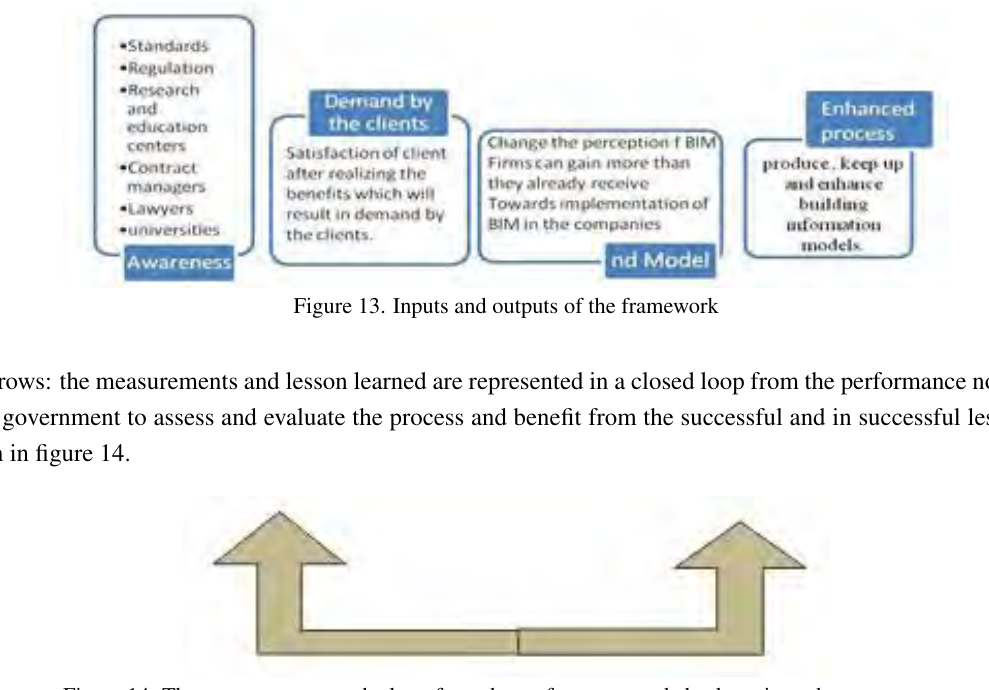
Figure 14. The arrow represents the loop from the performance node back again to the government